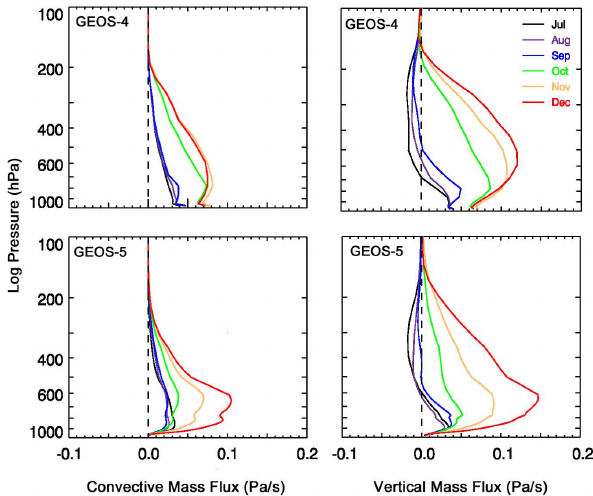
Fig. 11. Vertical profiles of convective air mass flux (left) and the total air mass flux (right, sum of convection and advection) in South America from August to December 2005. The top panels are for the model driven by GEOS-4 and the bottom panels are for the model driven by